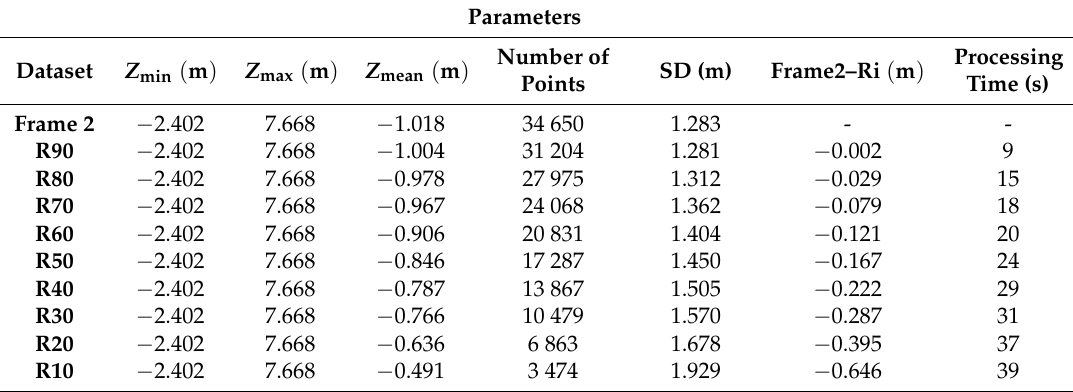
Table 2. Characteristics of obtained datasets after the OptD-single-MLS method for Frame 2.